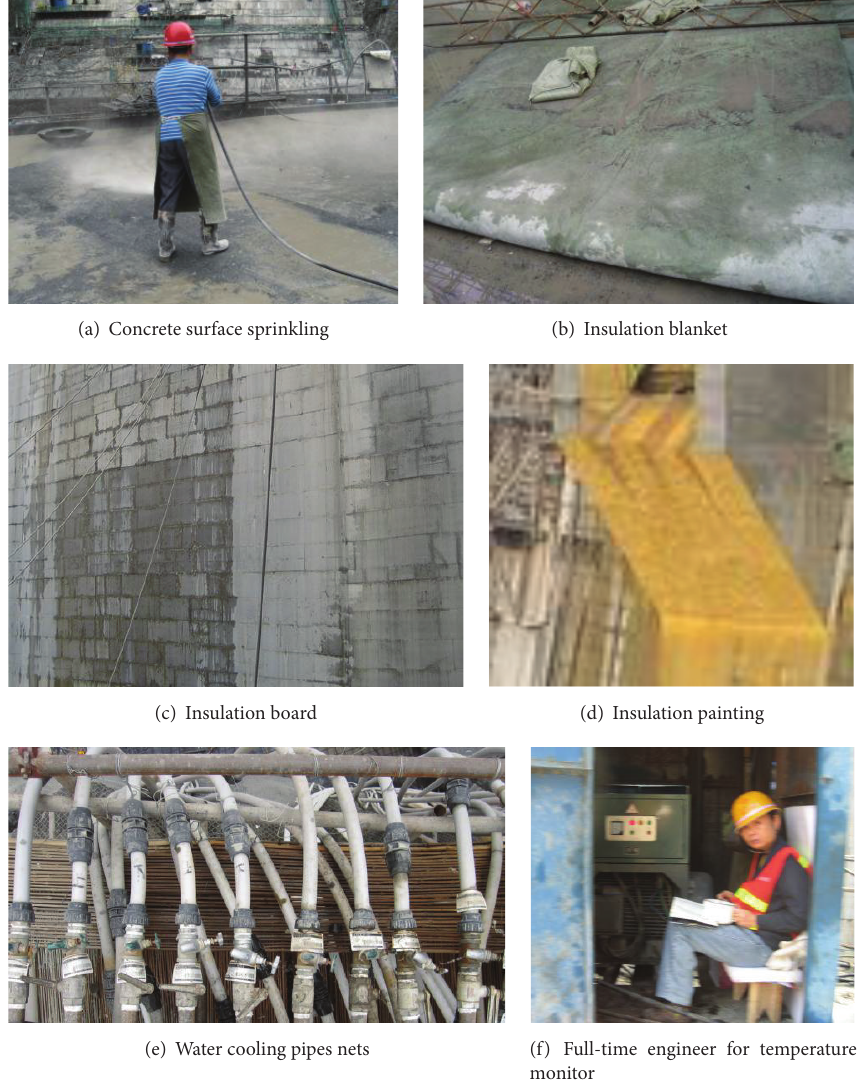
Figure 10: Systematic curing